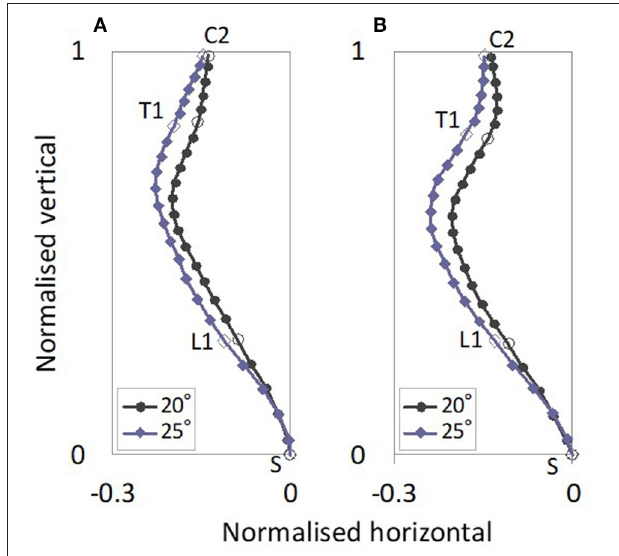
FIGURE 5 | Average gender-specific spinal alignments with 20 ◦ and 25 ◦ seat back angles. The average gender-specific spinal alignments were rotated back to the original position by average rotational angles for the female and male subjects in each posture, obtained in the normalization of the spinal alignment. (A) Female, (B)